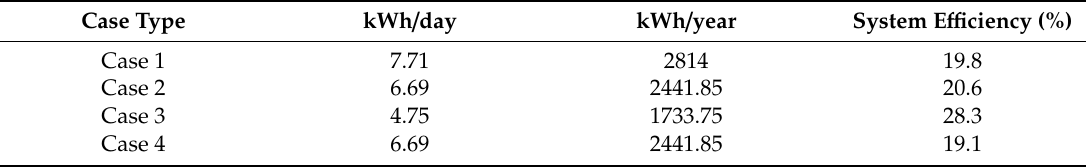
Table 7. Availability values and system efficiency for all cases.